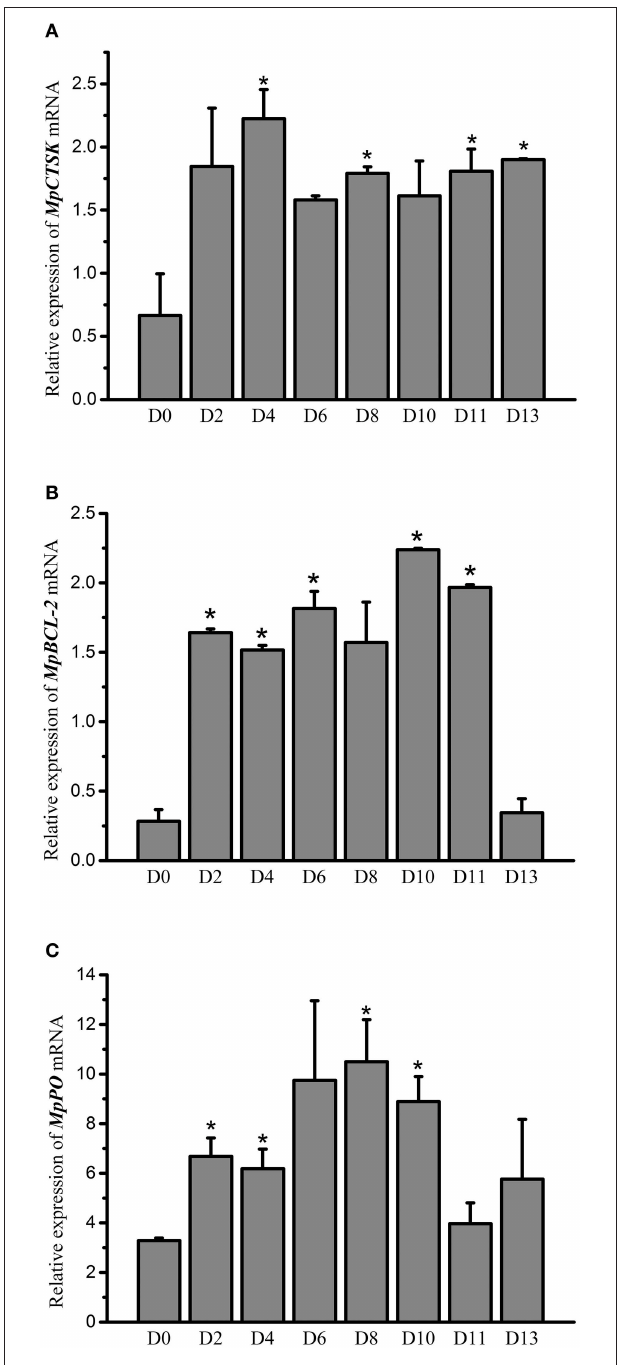
FIGURE 5 | Relative mRNA expression of MpCTSK (A) /MpBCL-2 (B) /MpPO (C) in the hepatopancreases of M. petechialis at 0–13 dpi after immersion in V. parahaemolyticus by qRT-PCR. Error bars represent the SD. The asterisk (*) represents significant differences found when compared to 0 dpi ( P < 0.05).